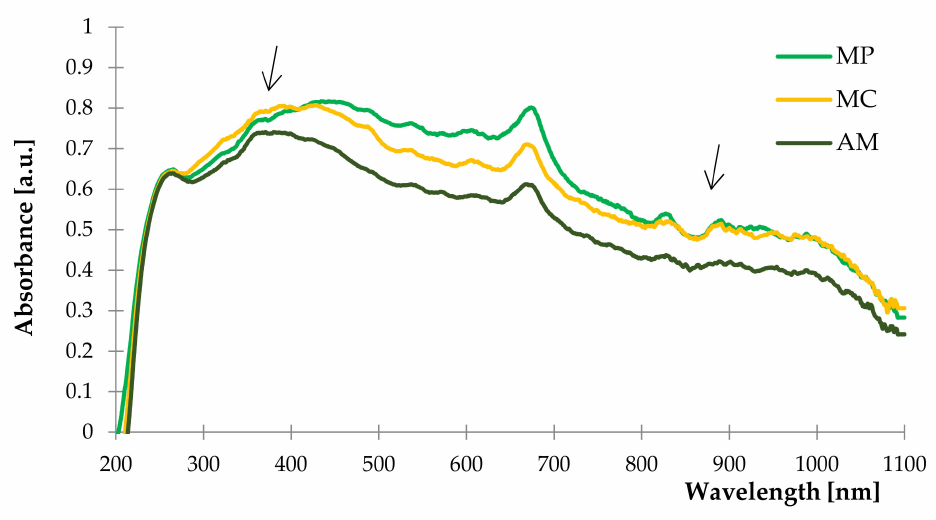
Figure 2. The UV–Vis spectra of peppermint (MP), German chamomile (MC) and yarrow (AM).